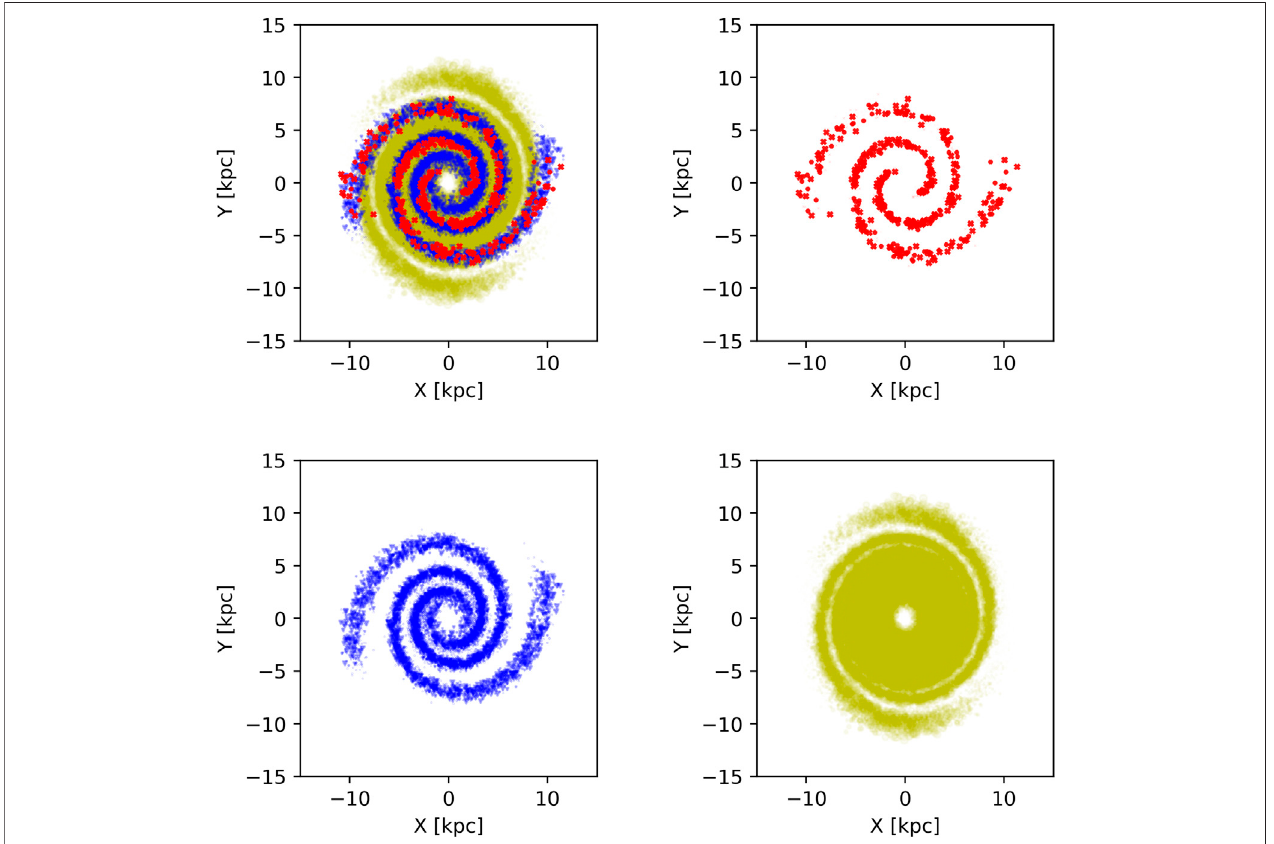
FIGURE10 | Maps ofthe cluster distribution estimated forakinematicmodel ofourGalaxy. The clusterswereseparated intothree groups: G6.5, G7.5, and G8.5. (A) : the composite picture of the distribution; red crosses and blue triangles follow the spiral arm quite closely. (B) : clusters with ages around 3.1 Myr. (C) : clusters with ages around 31 Myr. (D) : clusters with ages around 310